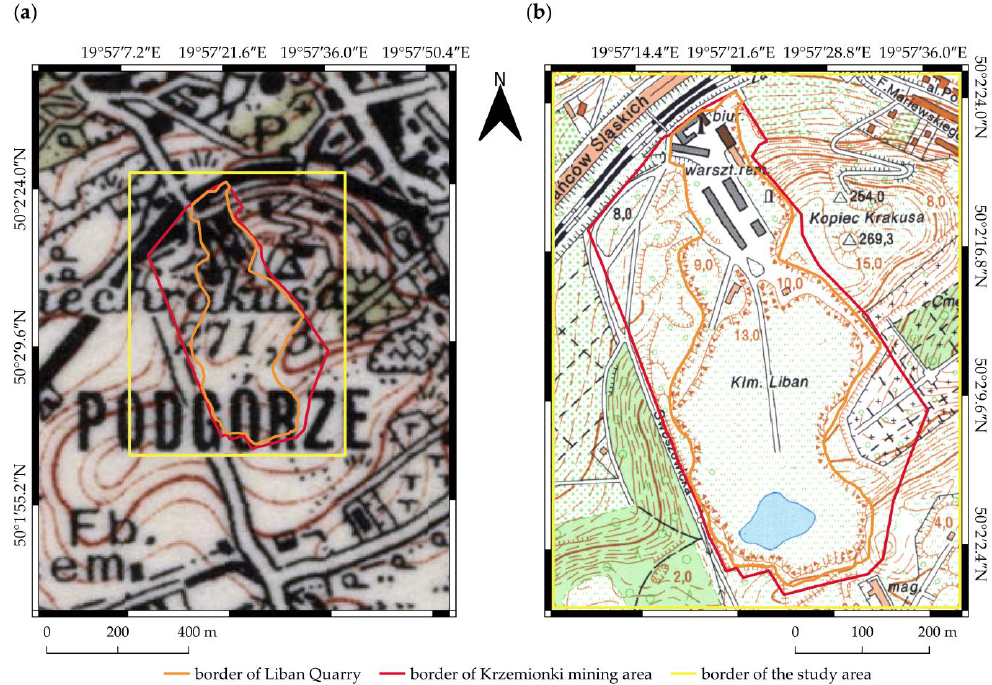
Figure 2. Krzemionki mining area and its surroundings: ( a ) part of the Tactical Map of Poland with a scale of 1:100,000 [24]; ( b ) part of the Topographic Map of Poland with a scale of 1:10,000